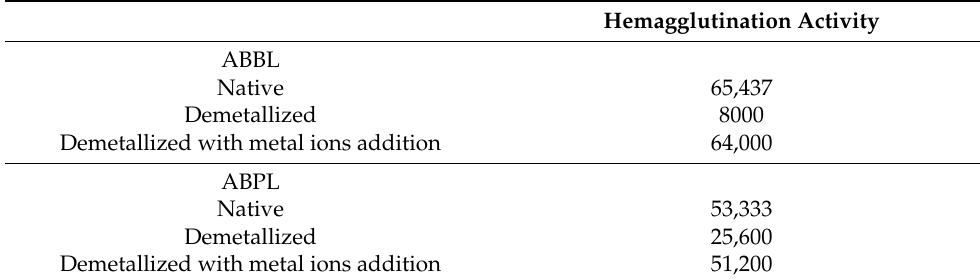
Table 3. Hemagglutinating activity of the lectins of two varieties of Phaseolus coccineus demetallized and with the addition of metals ions.